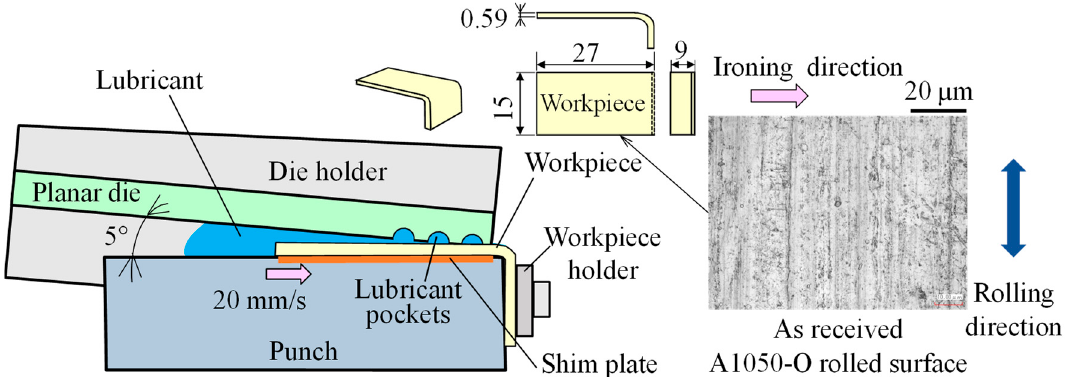
Figure 3. Strip ironing of aluminum alloy sheets illustrated in half-section view (scale in